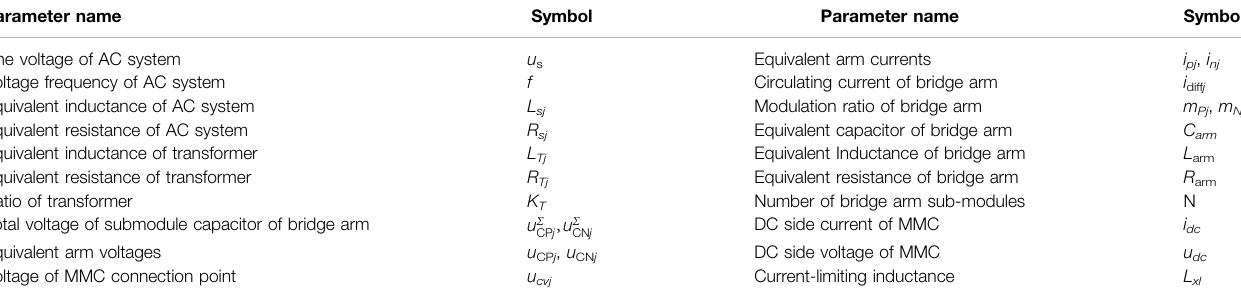
TABLE 1 | Parameters of the MMC